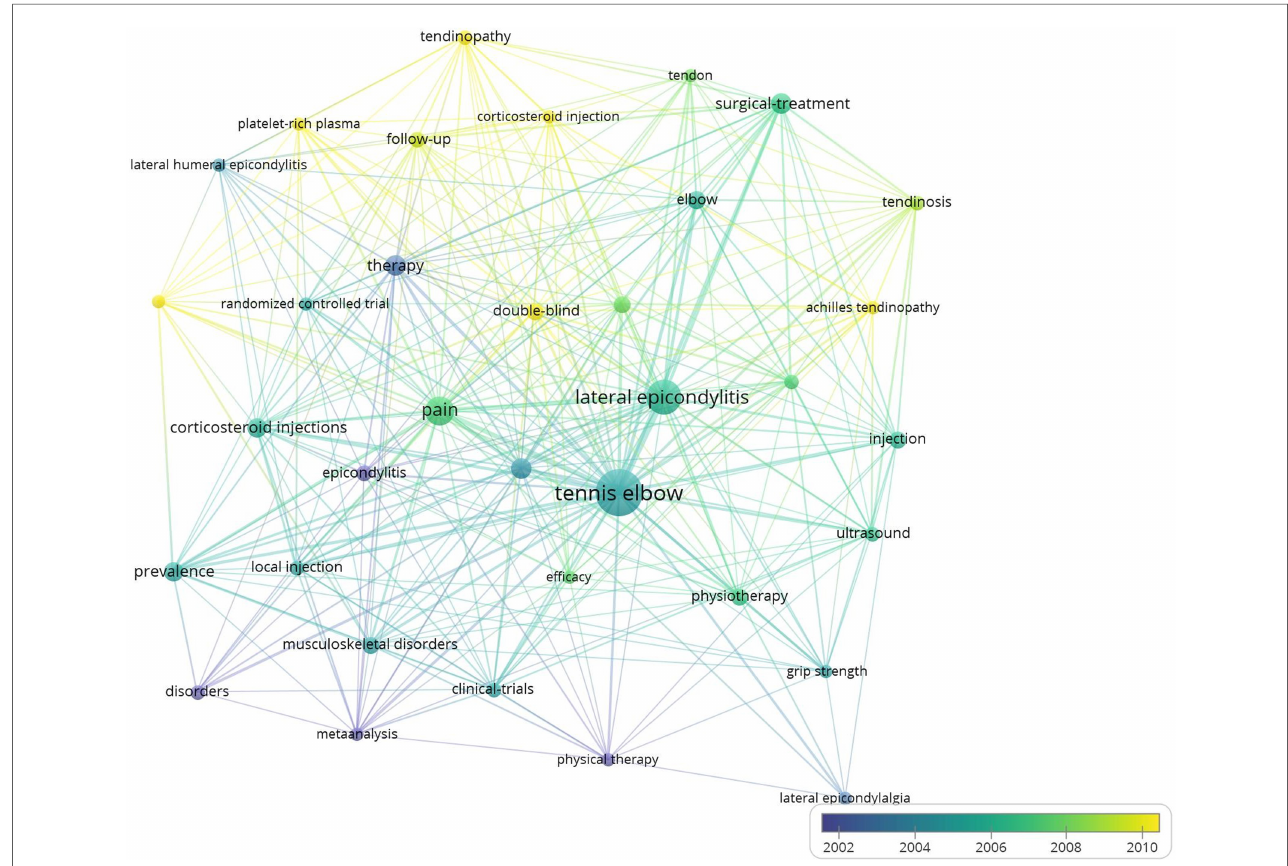
FIGURE 6 Network visualization map showing cluster analysis of tennis elbow related keywords. Note: The size of each circle represents the number of occurrences, and the more times, the larger the circle. In cluster analysis, different colors indicate different